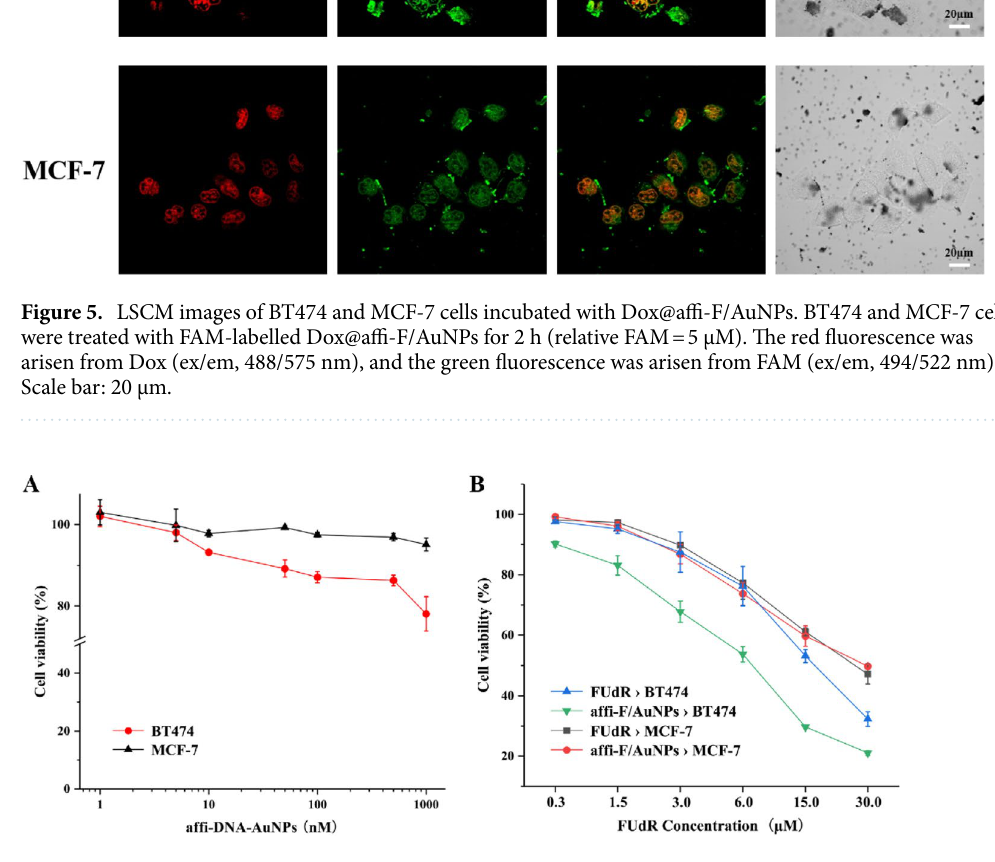
Figure 6. Cytotoxicity assay of affi-DNA-AuNPs and affi-F/AuNPs. ( A ) Cell viability of BT474 and MCF-7 cells incubated with different concentrations of affi-DNA-AuNPs. ( B ) Cell viability of BT474 and MCF-7 cells treated with different concentrations of